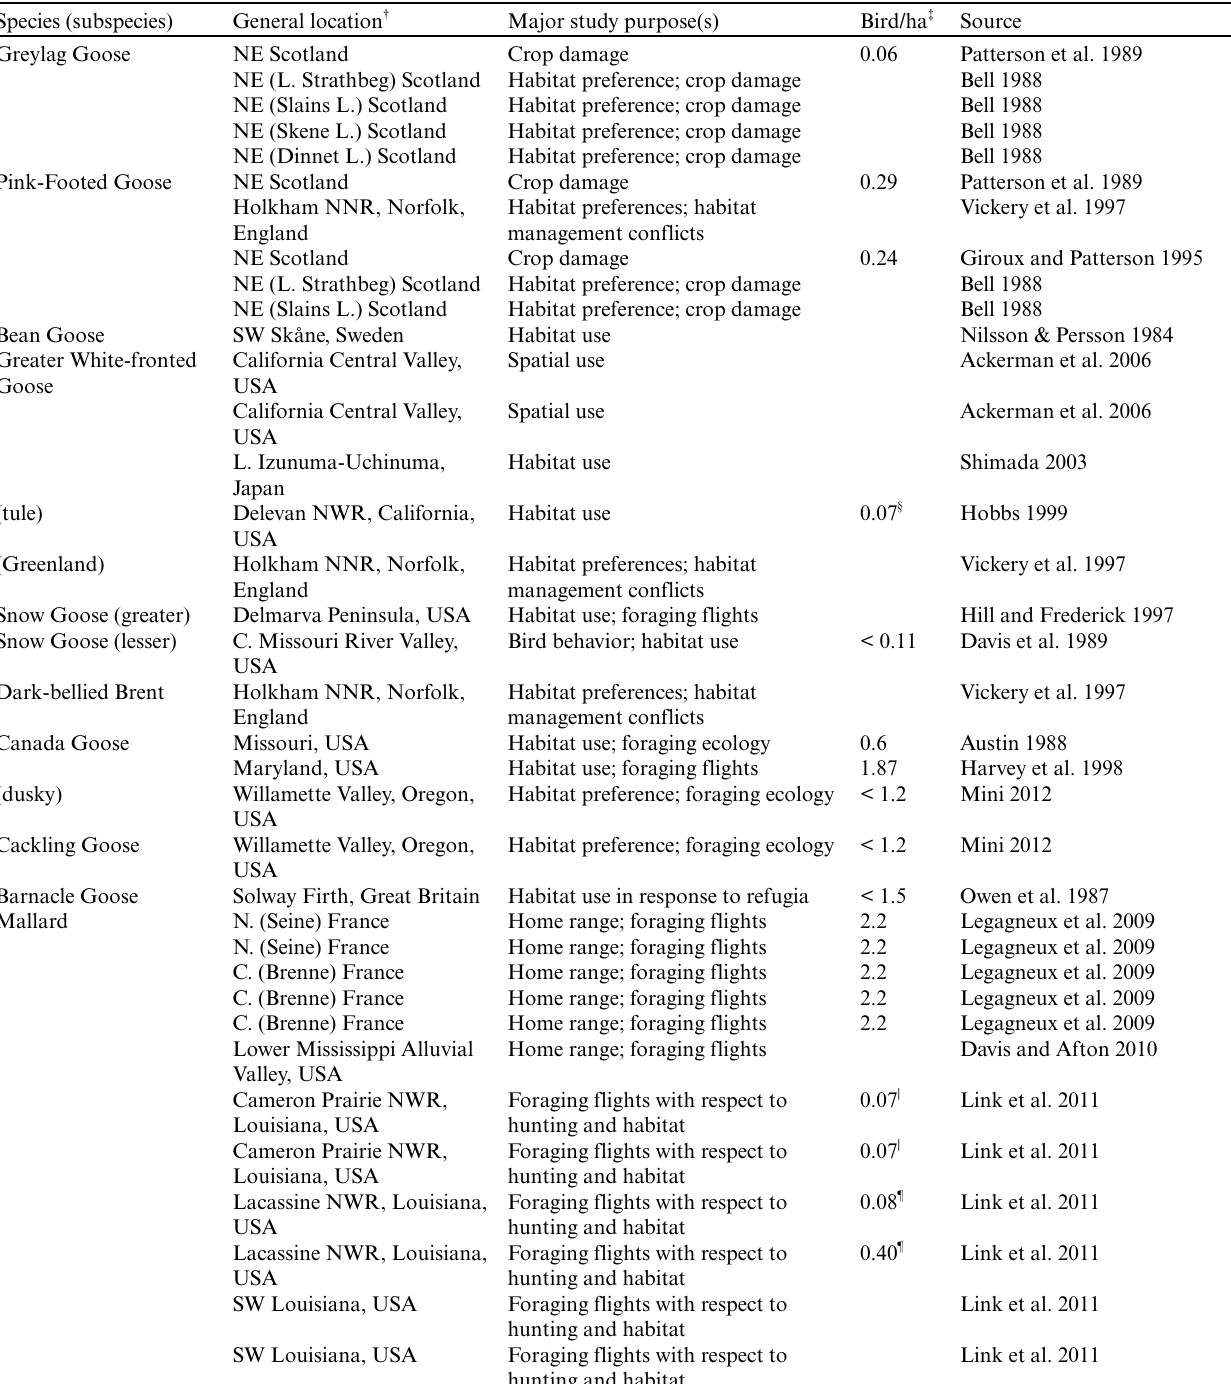
Table 4 . Study purpose and density (birds/ha; when available) associated with foraging flight distance (FFD) values used to evaluate the influence of guild, mass, and location on distances flown by waterfowl between roost and foraging areas. Scientific names for all species listed in Appendix